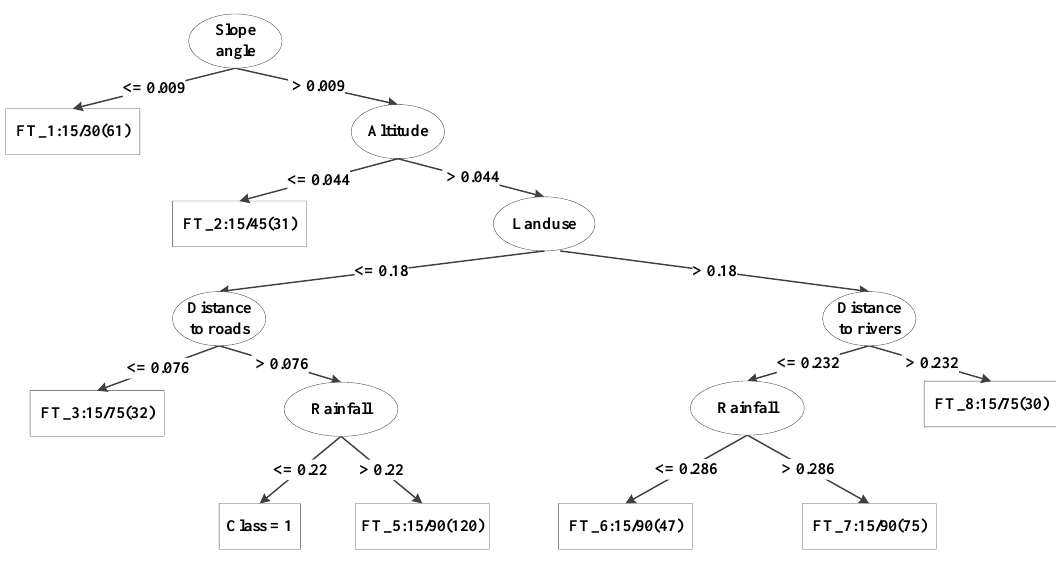
Figure 8. Classification decision tree of landslide susceptibility using the function tree (FT) model.